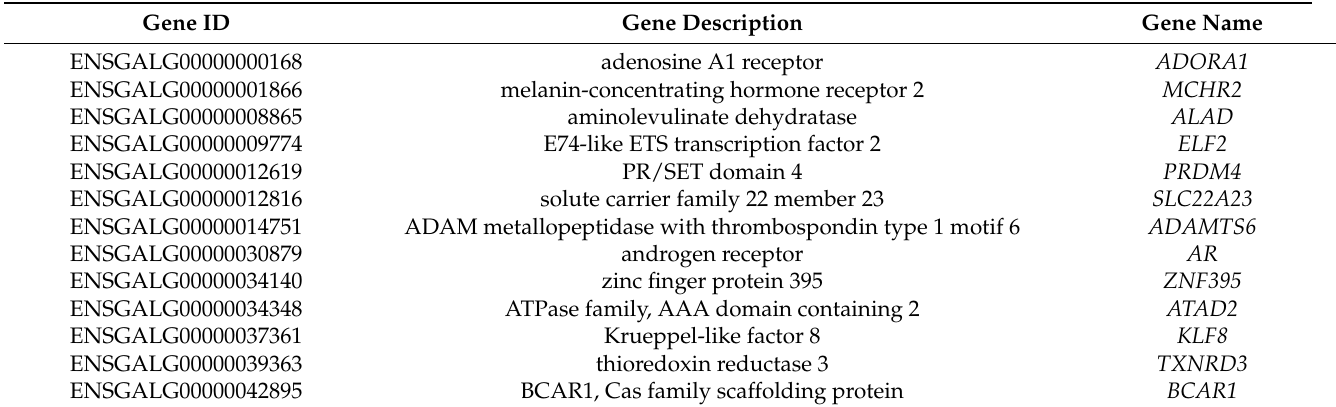
Table 2. Hub genes associated with H/L ratio in blue module in